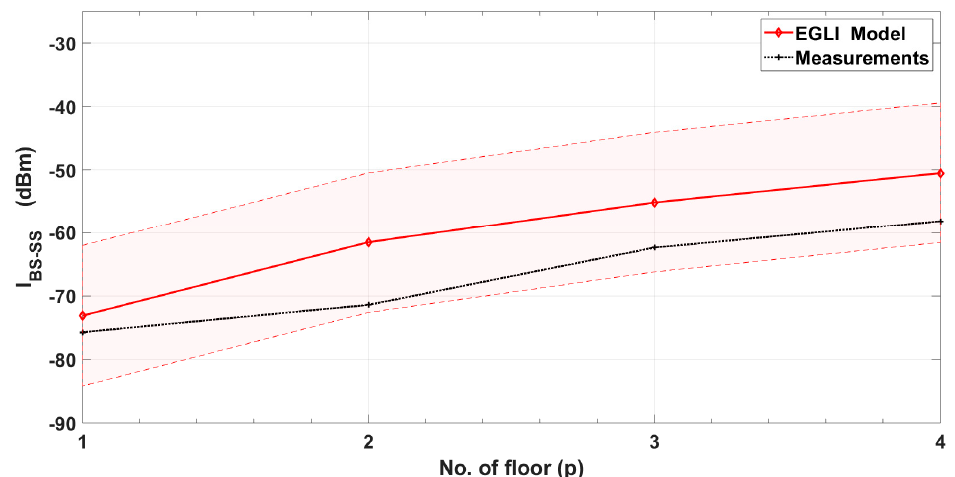
Figure 9. Behavior of the simulated interference levels using the EGLI model, CI = 95%, in the apartments of the middle sector of the building compared with the measurements.